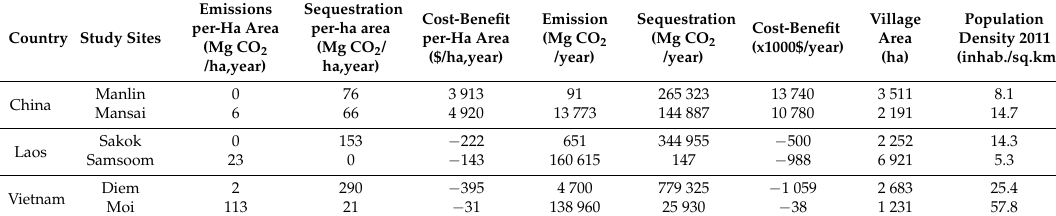
Table 2. Outputs of the REDD Abacus software for the six study sites over the period